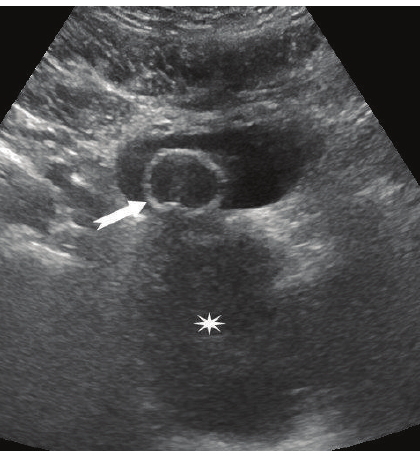
Figure 1: Pelvic ultrasound. A large hypoechoic mass (asterisk) is seen in the prostatic loggia. The arrow indicates the urinary catheter.